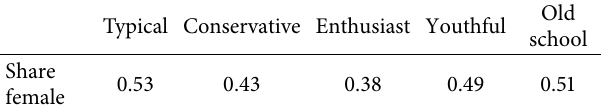
Table 4: Share of female